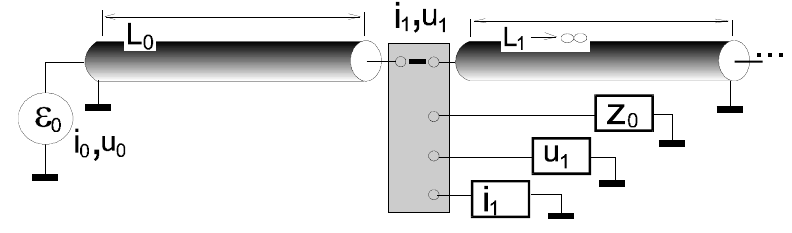
); i , u - 0 0 0 before 0 ), when the source ε "does not feel" the 0 0 → ∞ ) line of transmission: active source 1